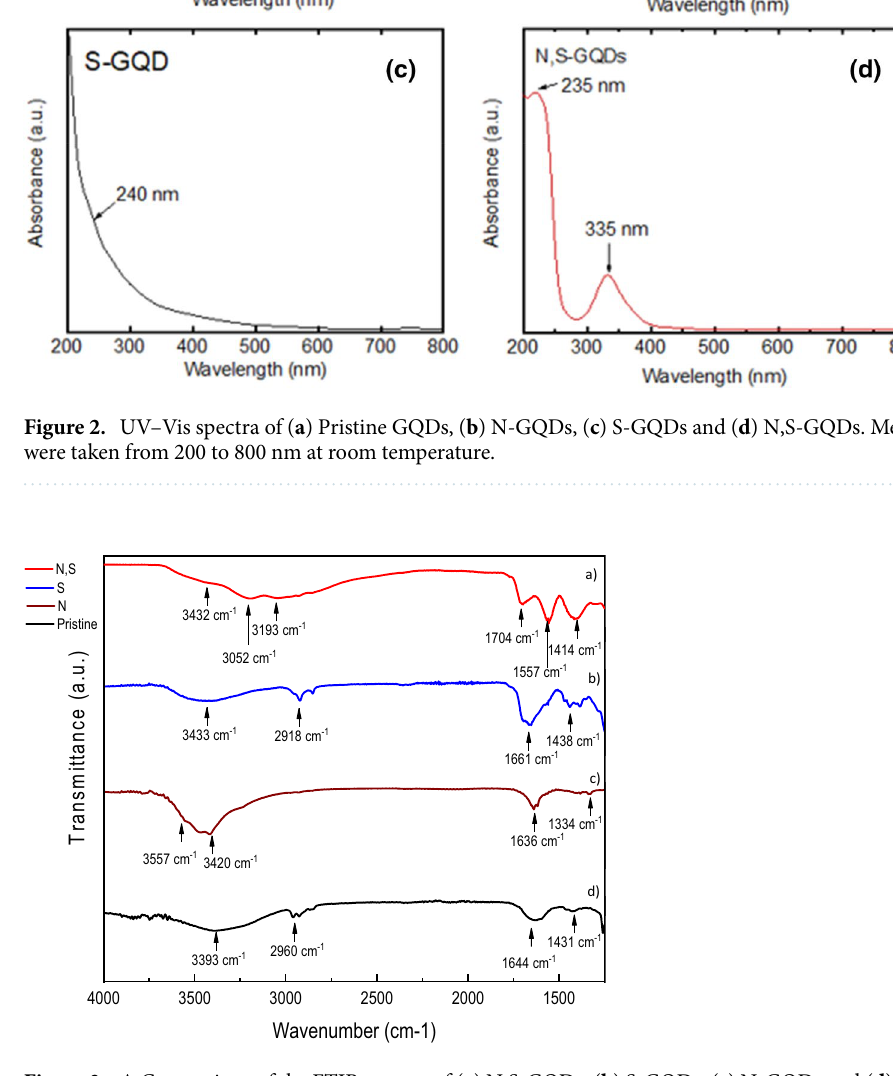
Figure 3. A Comparison of the FTIR spectra of ( a ) N,S-GQDs, ( b ) S-GQDs, ( c ) N-GQDs and ( d ) Pristine